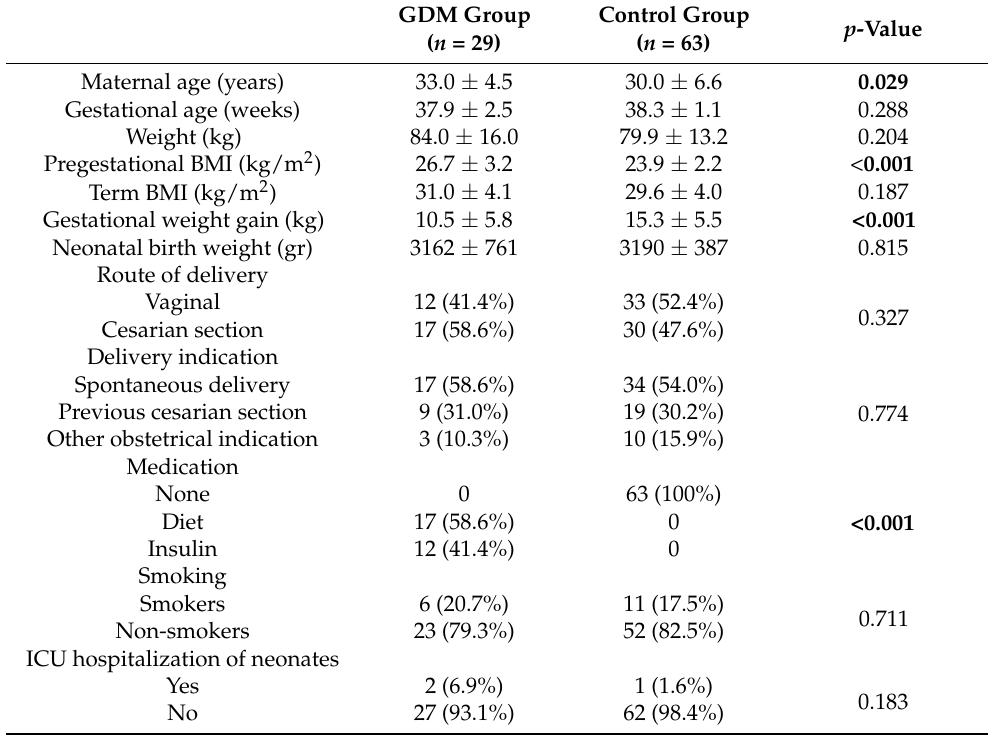
Table 1. Baseline parameters of study participants.